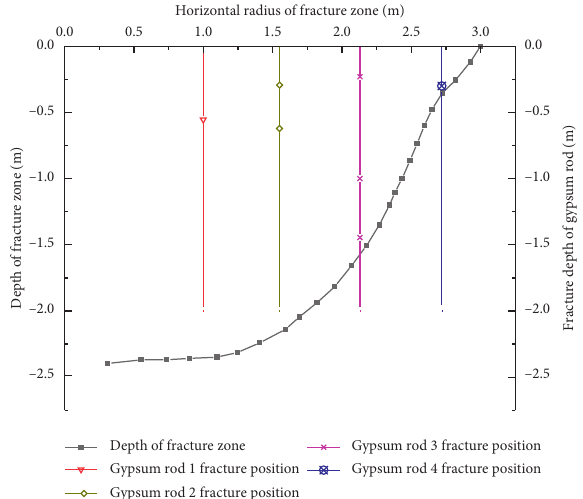
Figure 16: Comparison of the range of fracture zones in the blasting